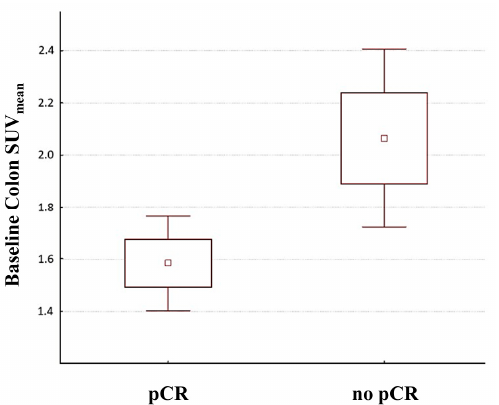
Figure 4. Distribution of baseline colon SUV mean values in patients who subsequently experienced pCR after NAC compared to no pCR patients. The mean value for each group is indicated by a central square. Boxes indicate the Standard Error. Whiskers represent 1.96 × Standard Error. NAC, neoadjuvant chemotherapy; SUV mean , mean standardized uptake value.